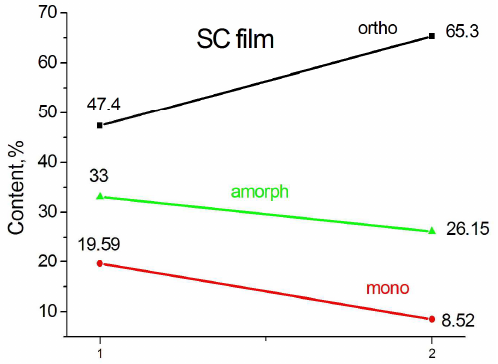
Figure 9. Phase composition of SC compressed film at 5 GPa (1) after its heating to 370 K and fast cooling to room temperature (2).